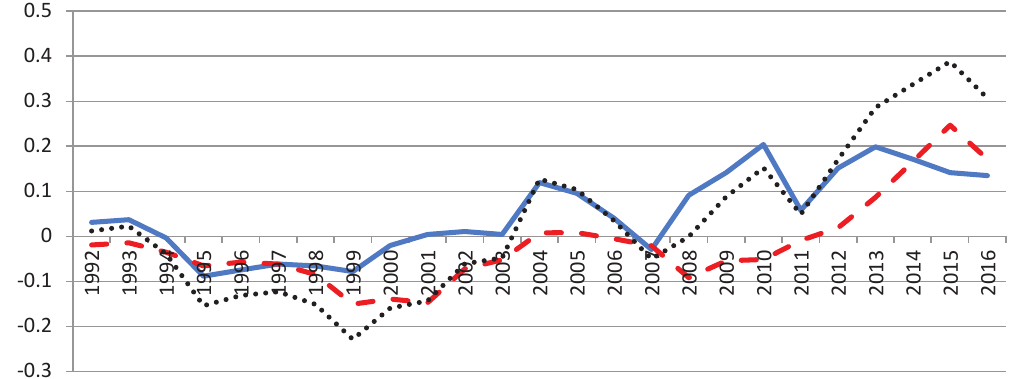
Figure 1 Contribution of composition effects to the wage growth, distinguishing between employers’ and workers’ characteristics.